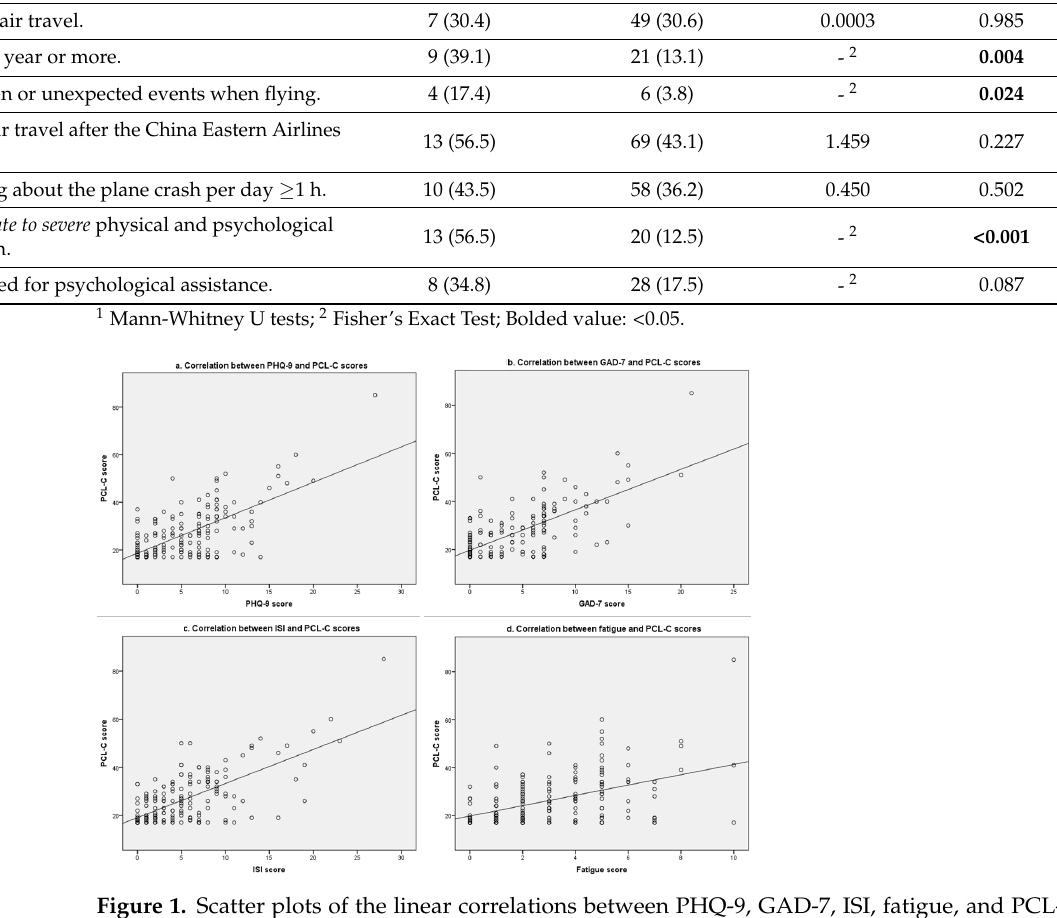
Figure 1. Scatter plots of the linear correlations between PHQ-9, GAD-7, ISI, fatigue, and PCL-C scores among flight and train attendant students. scores among flight and train attendant